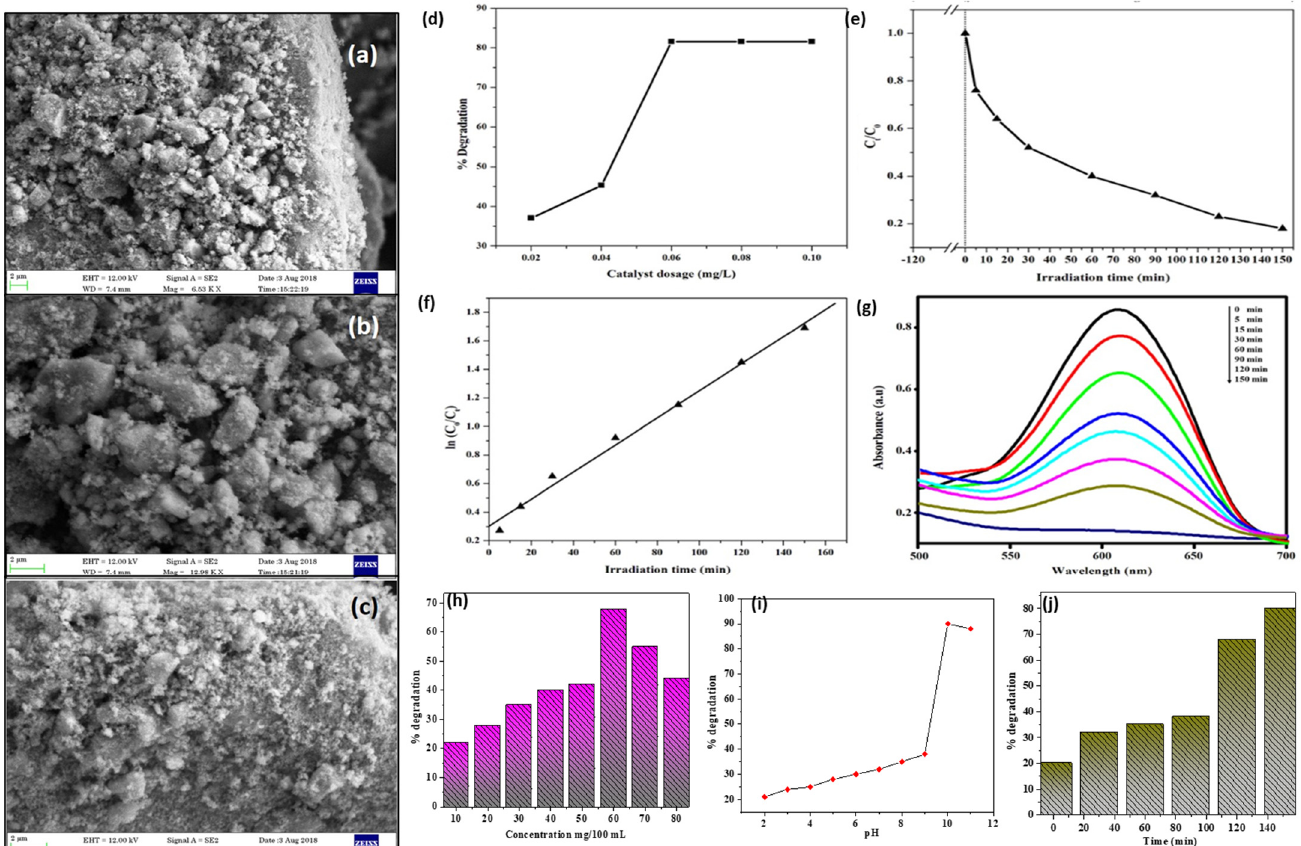
Figure 6. ( a – c ) FESEM micrographs of green synthesized GGCo-NPs nanoparticles. ( d ) Effect of initial catalytic dose. ( e ) Photocatalytic degradation of AB-74 by GCo-NPs under irradiation by sunlight. ( f ) Pseudo-first-order reaction kinetic model for GCo-NPs as an NP photocatalyst. ( g ) Absorption spectrum of photocatalytically degraded AB-74 at different time intervals. Photocatalytic degradation of AB-74, with varying initial dye concentrations (10 mg/100 mL–80 mg/100mL) ( h ), pH (2–12) ( i ), contact time (0–150 min) ( j ) [33].